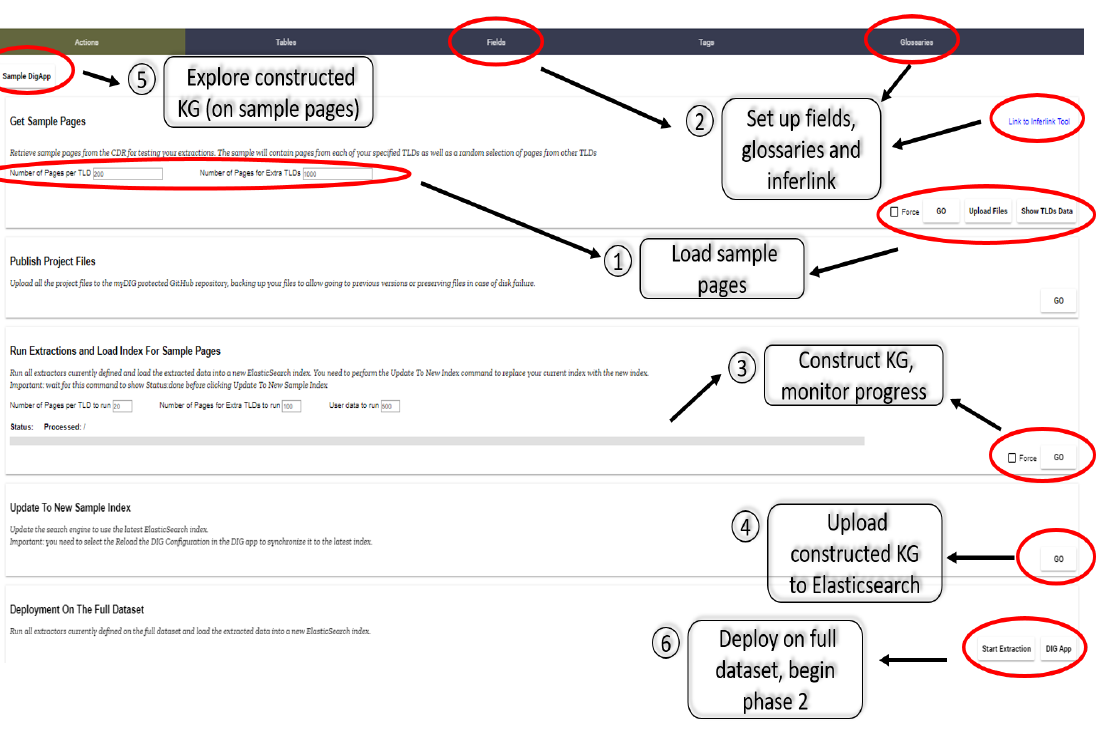
Figure 1. The myDIG dashboard, with corresponding elements and